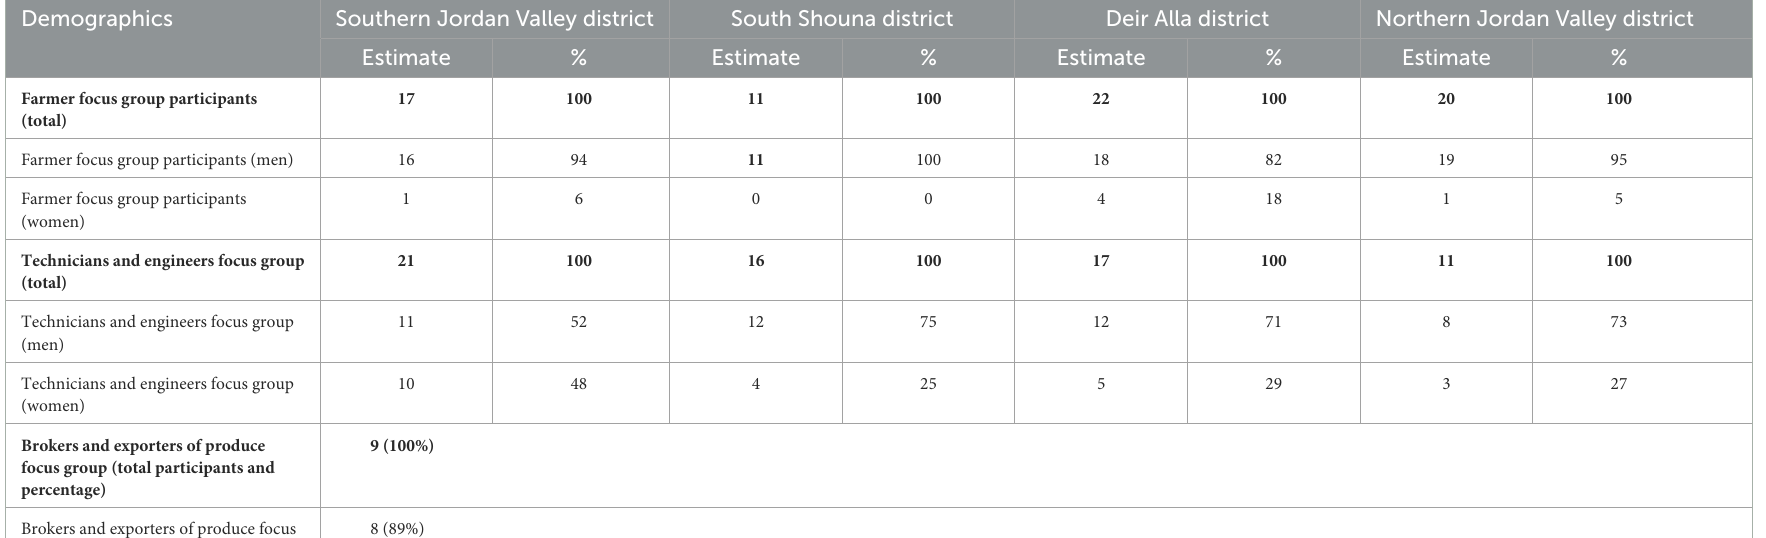
TABLE 2 Main demographic characteristics of the study participants from the four districts of the Jordan Valley (bold values indicate sums of sub-values beneath).